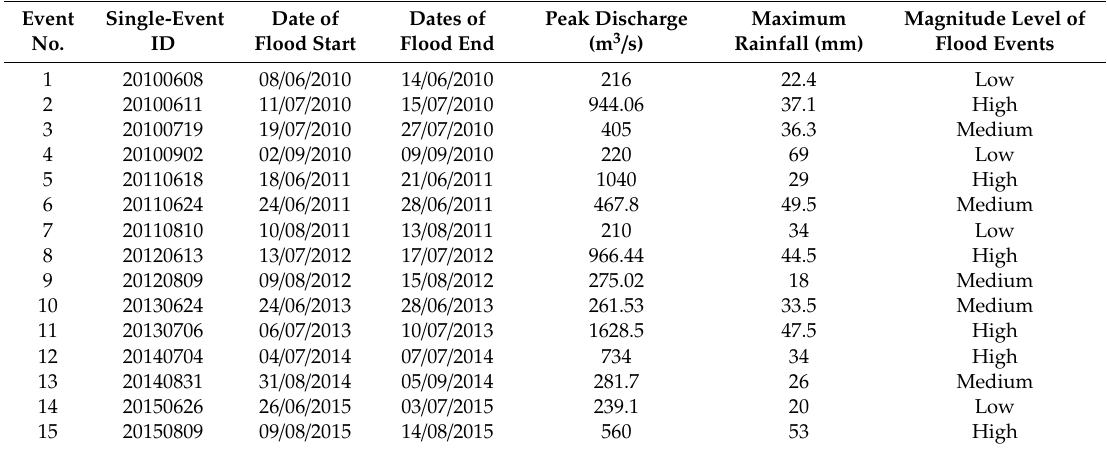
Table 1. Characteristics of the selected rainfall–runo ff events for this